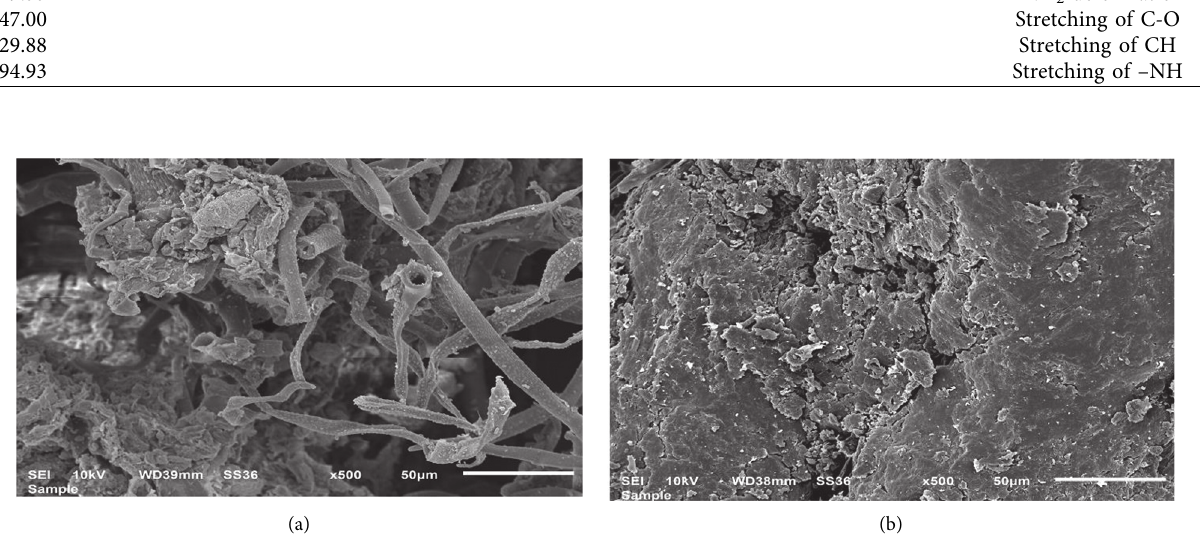
Figure 1: SEM spectrum of ZCOBLP (a) before and (b) after